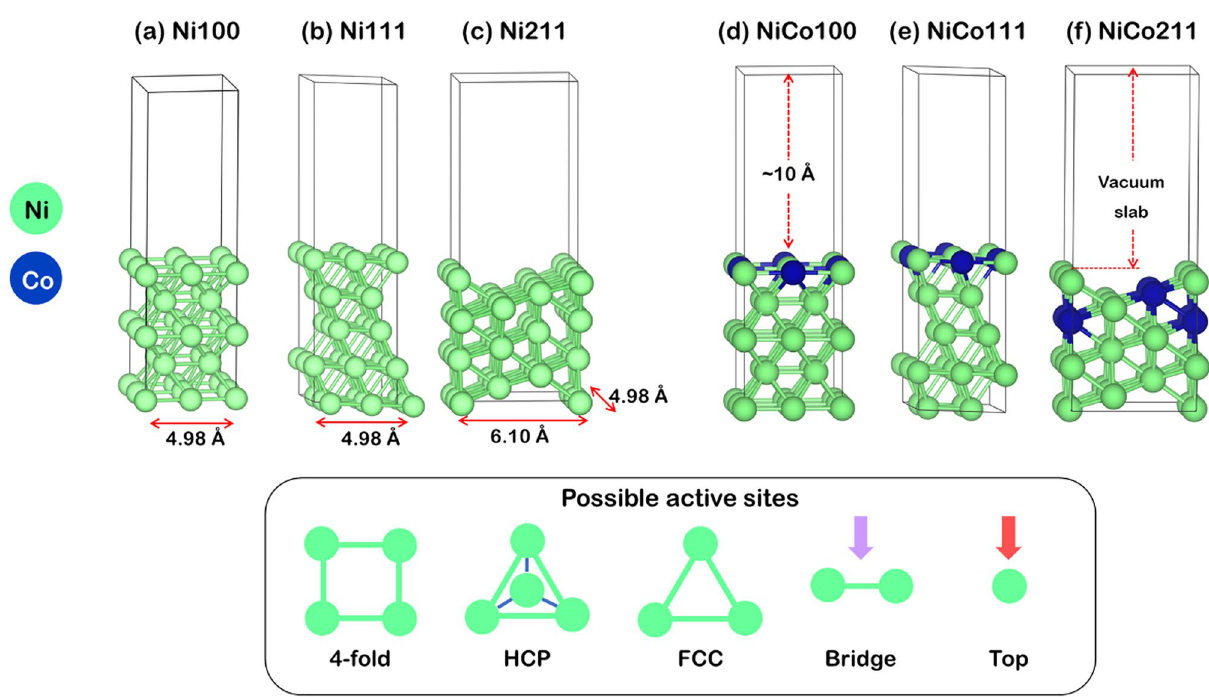
Figure 2. Surface slab models of ( a ) Ni100, ( b ) Ni111, ( c ) Ni211, ( d ) NiCo100, ( e ) NiCo111, and ( f ) NiCo211, where and possible active sites are fourfold, HCP, FCC, Bridge, and Top